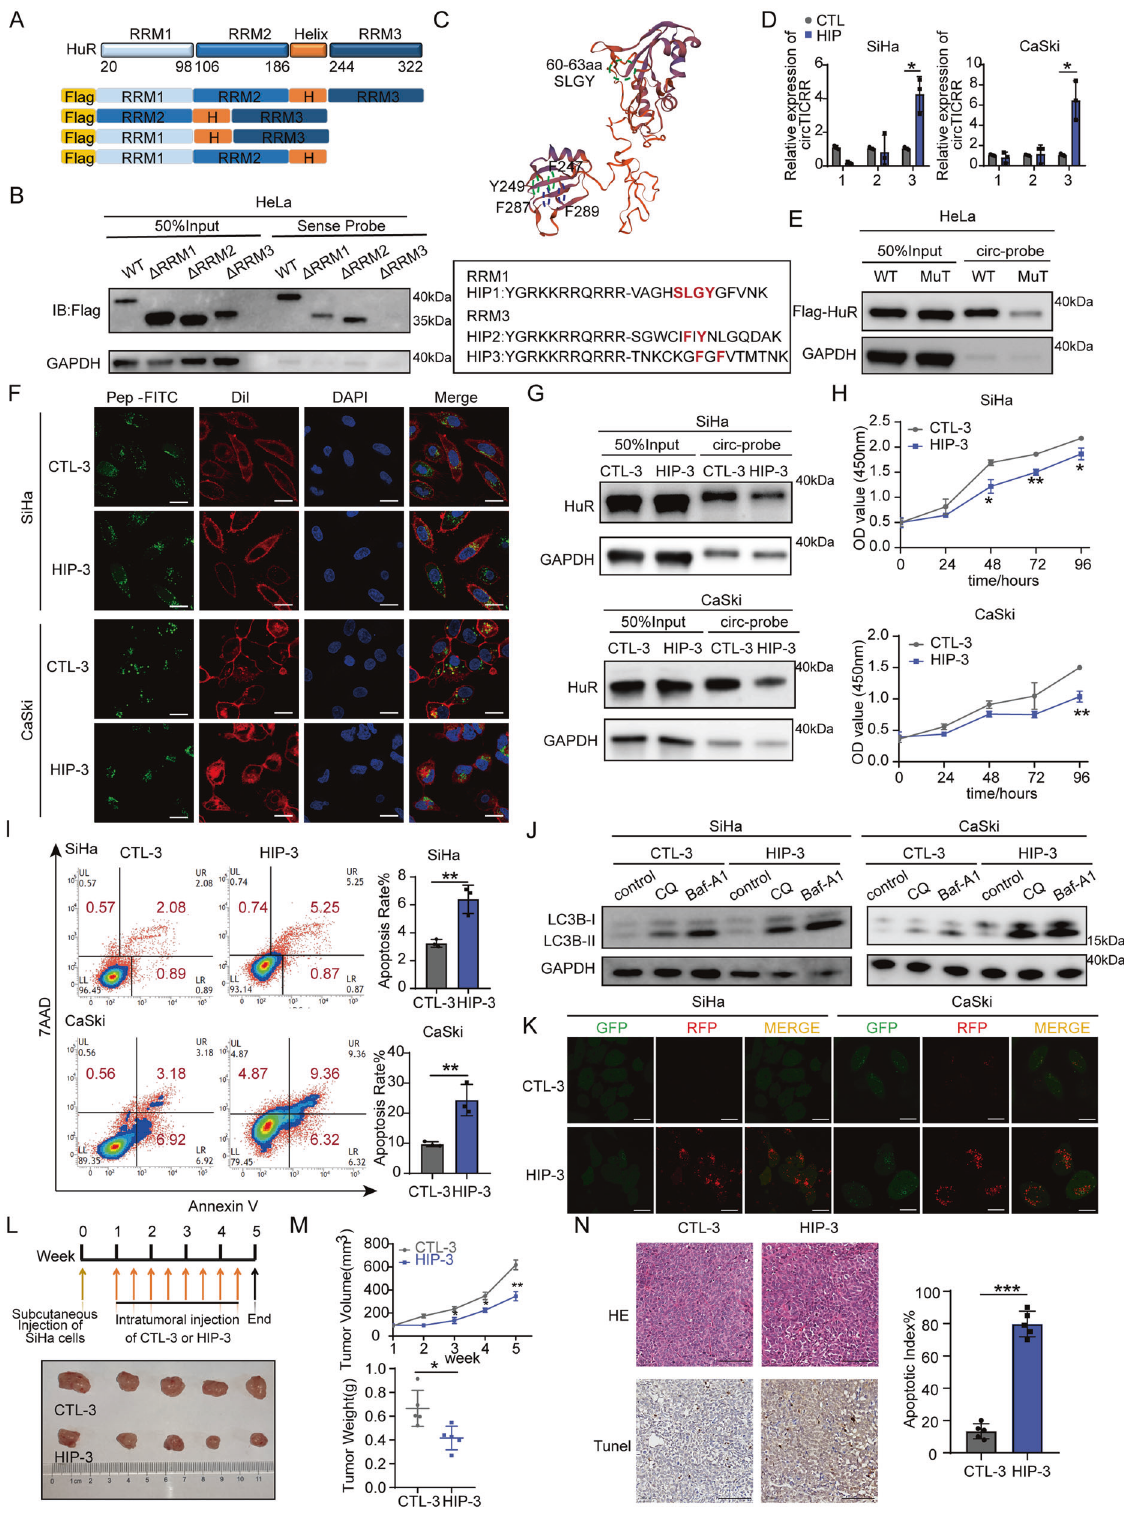
Biotin-labeled peptide pull-down Biotin-labeled peptides (30 μ mol/l) were incubated with extracted total RNA at 4 °C overnight. Then, the RNA-peptide complex was incubated with streptavidin magnetic beads (Thermo Scienti fi c, 88817) at 4 °C for 2 h. After four washes, RNAs attached to the beads were extracted and measured by qRT-PCR.